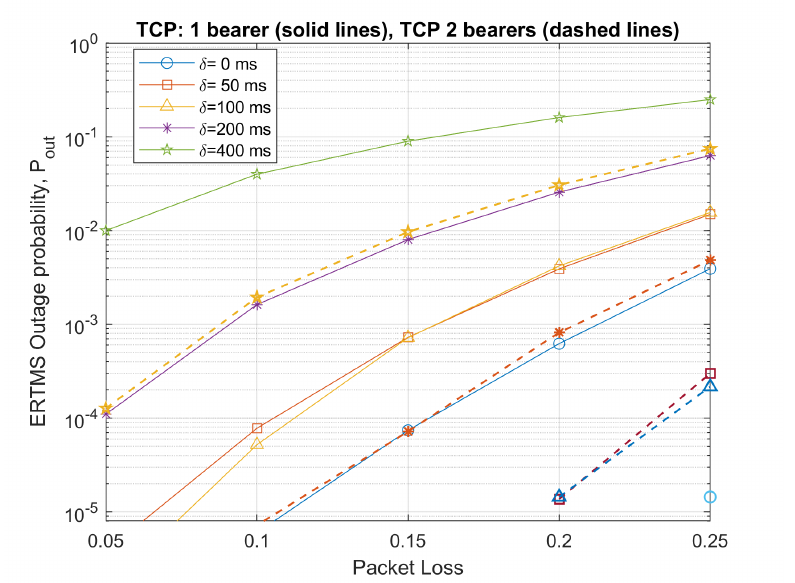
Figure 13. PR/MA over-limit percentage vs. network packet losses for 1 TCP bearer and 2 TCP bearers: considered delays are 0, 50, 100, 200 and 400